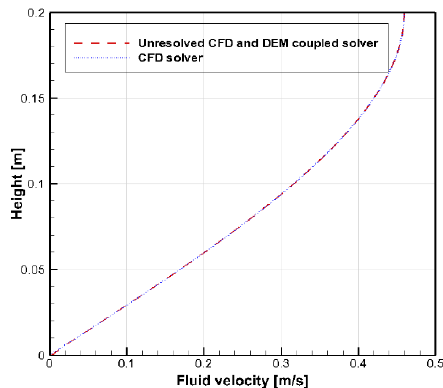
Figure 2. Velocity profile by unresolved CFD and DEM solver, and CFD solver.